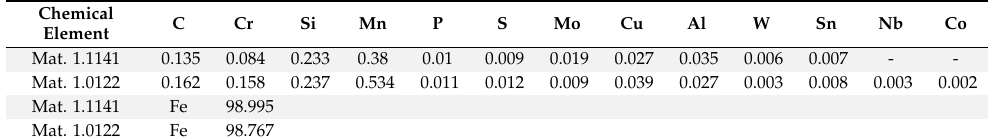
Table 1. Chemical composition (wt %) of the investigated materials (Fe is